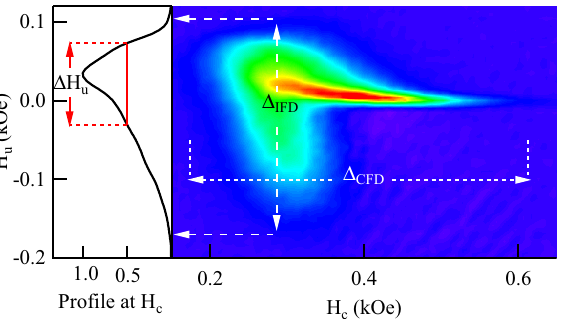
Figure 1. FORC diagram plotted in the H c , H u plane measured for the sample S17 (Ni, φ =100nm, P =2.0%), where the measured quantities are indicated: the interaction field distribution (cid:31) IFD , the coercive field distribution (cid:31) CFD and (cid:31) H u